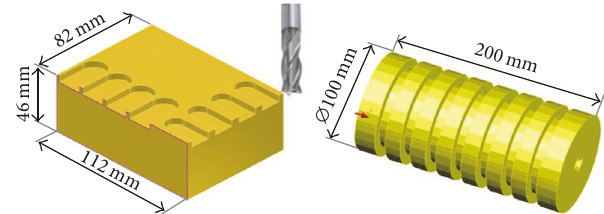
Figure 2: CAD models of the test